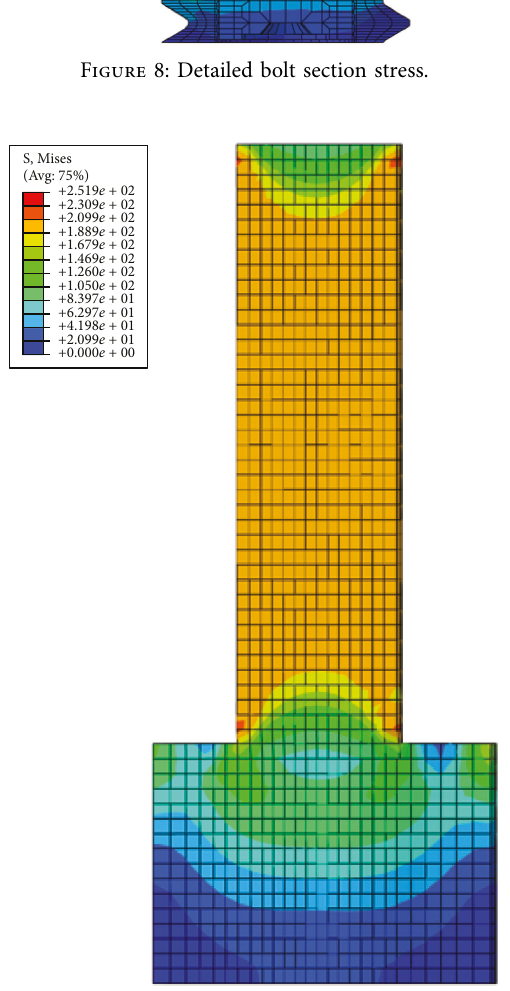
Figure 9: Simplified bolt section stress (after preload process).